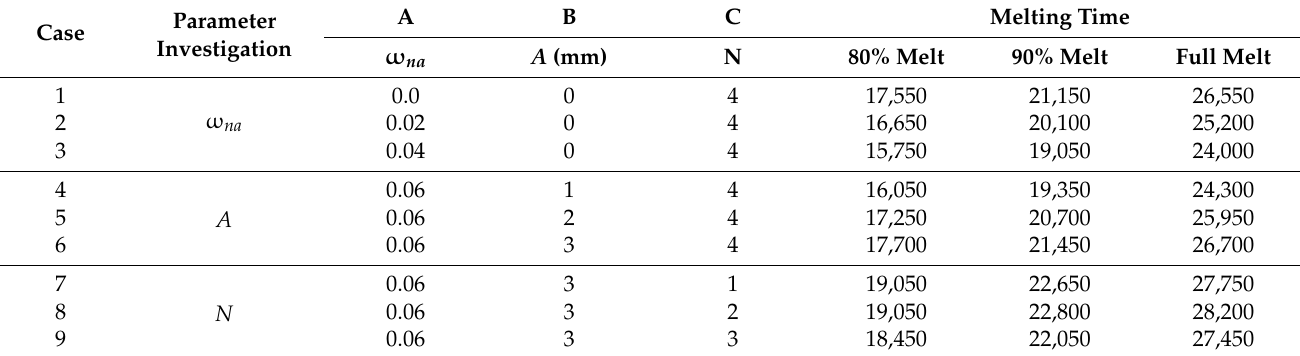
Table 7. Further investigation on the impact of design parameters around the optimum point for